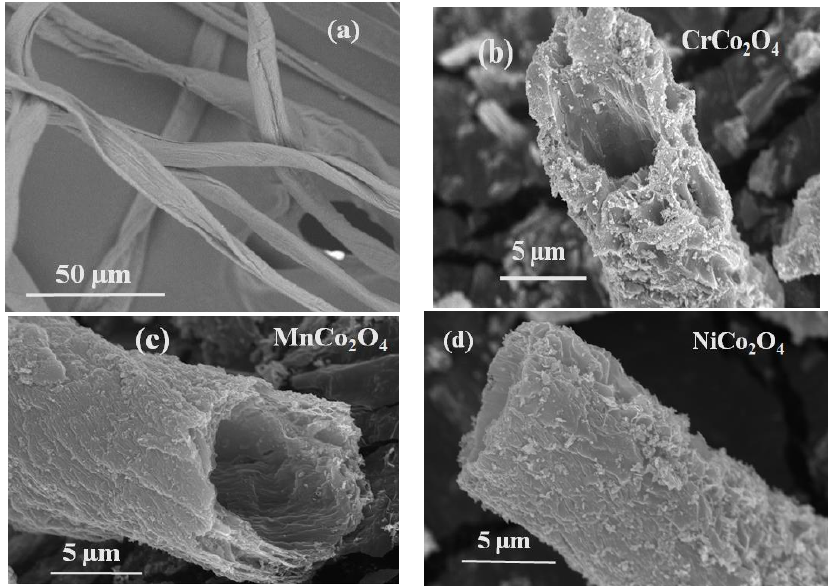
Figure 2. SEM images of ( a ) cotton fiber, ( b ), ( c ), and ( d ) bio-templated tubular MCo 2 O 4 (M = Cr, Mn, Ni) structures.